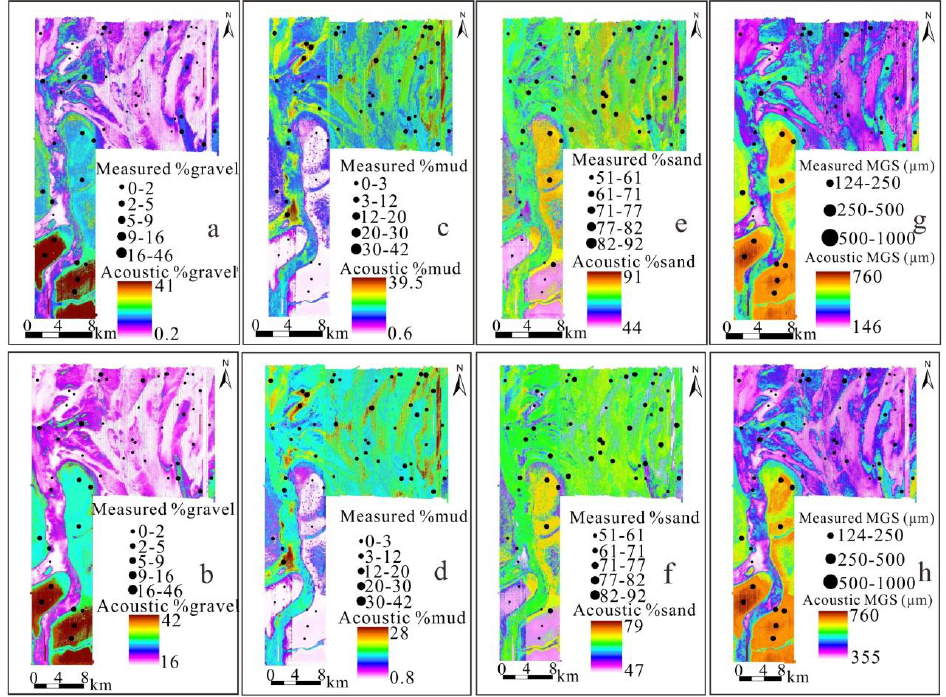
Figure 4. Predictive mapping of acoustic sediment properties in the BP_A overlapped with the measured sediment properties. When BM and BS were set as explanatory variable: ( a ), the predictive mapping of acoustic %gravel; ( c ), the predictive mapping of acoustic %mud; ( e ), the predictive mapping of acoustic %sand; ( g ), the predictive mapping of acoustic MGS. When only BS was set as explanatory variable: ( b ), the predictive mapping of acoustic %gravel; ( d ), the predictive mapping of acoustic %mud; ( f ), the predictive mapping of acoustic %sand; ( h ), the predictive mapping of acoustic MGS.